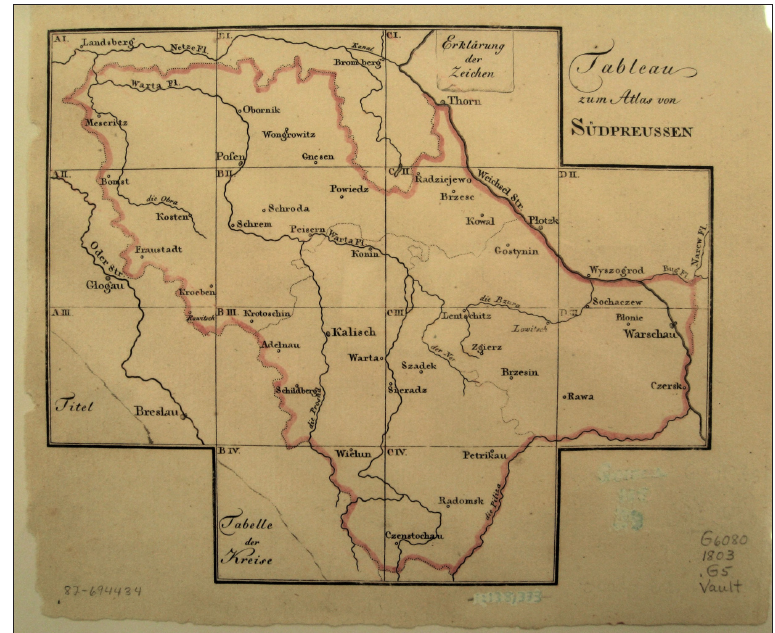
Figure 4: Quadrants of the map of South Prussia. Source: Gilly, Special Karte. Tableau zum Atlas von Südpreussen. Source: Library of Congress, Geography and Maps Division (G6080 1803 .G51). Photographed by the author with permission of the Library of Congress, Geography and Maps Division.